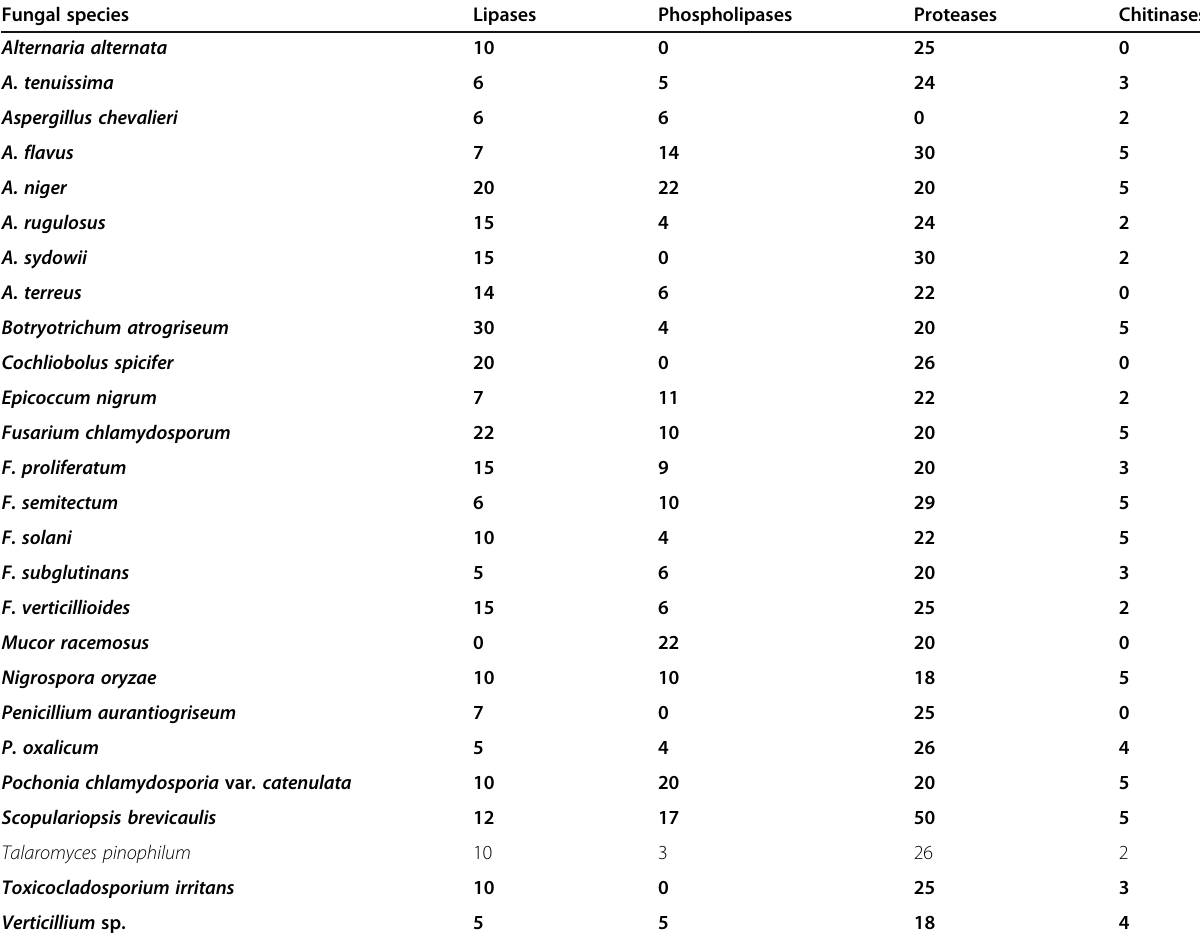
Table 2 Enzymatic activities of isolated fungal species lipases, phospholipases, proteases, and chitinases expressed as depth of activity zone in mm Fungal